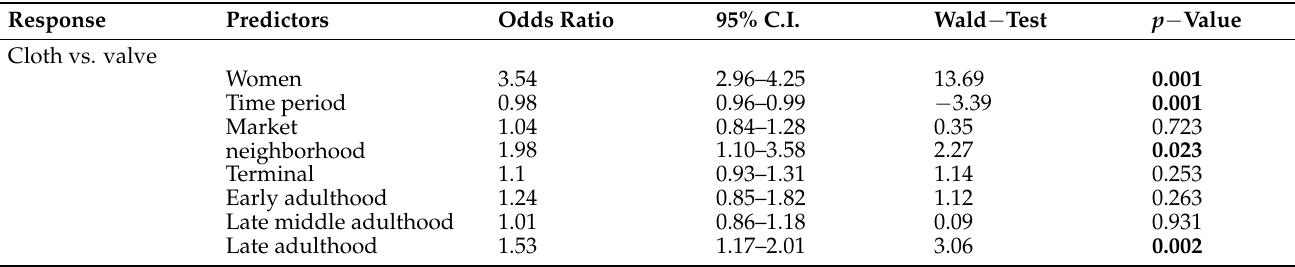
Table 1. Odds ratio based on the multinomial logistic regression